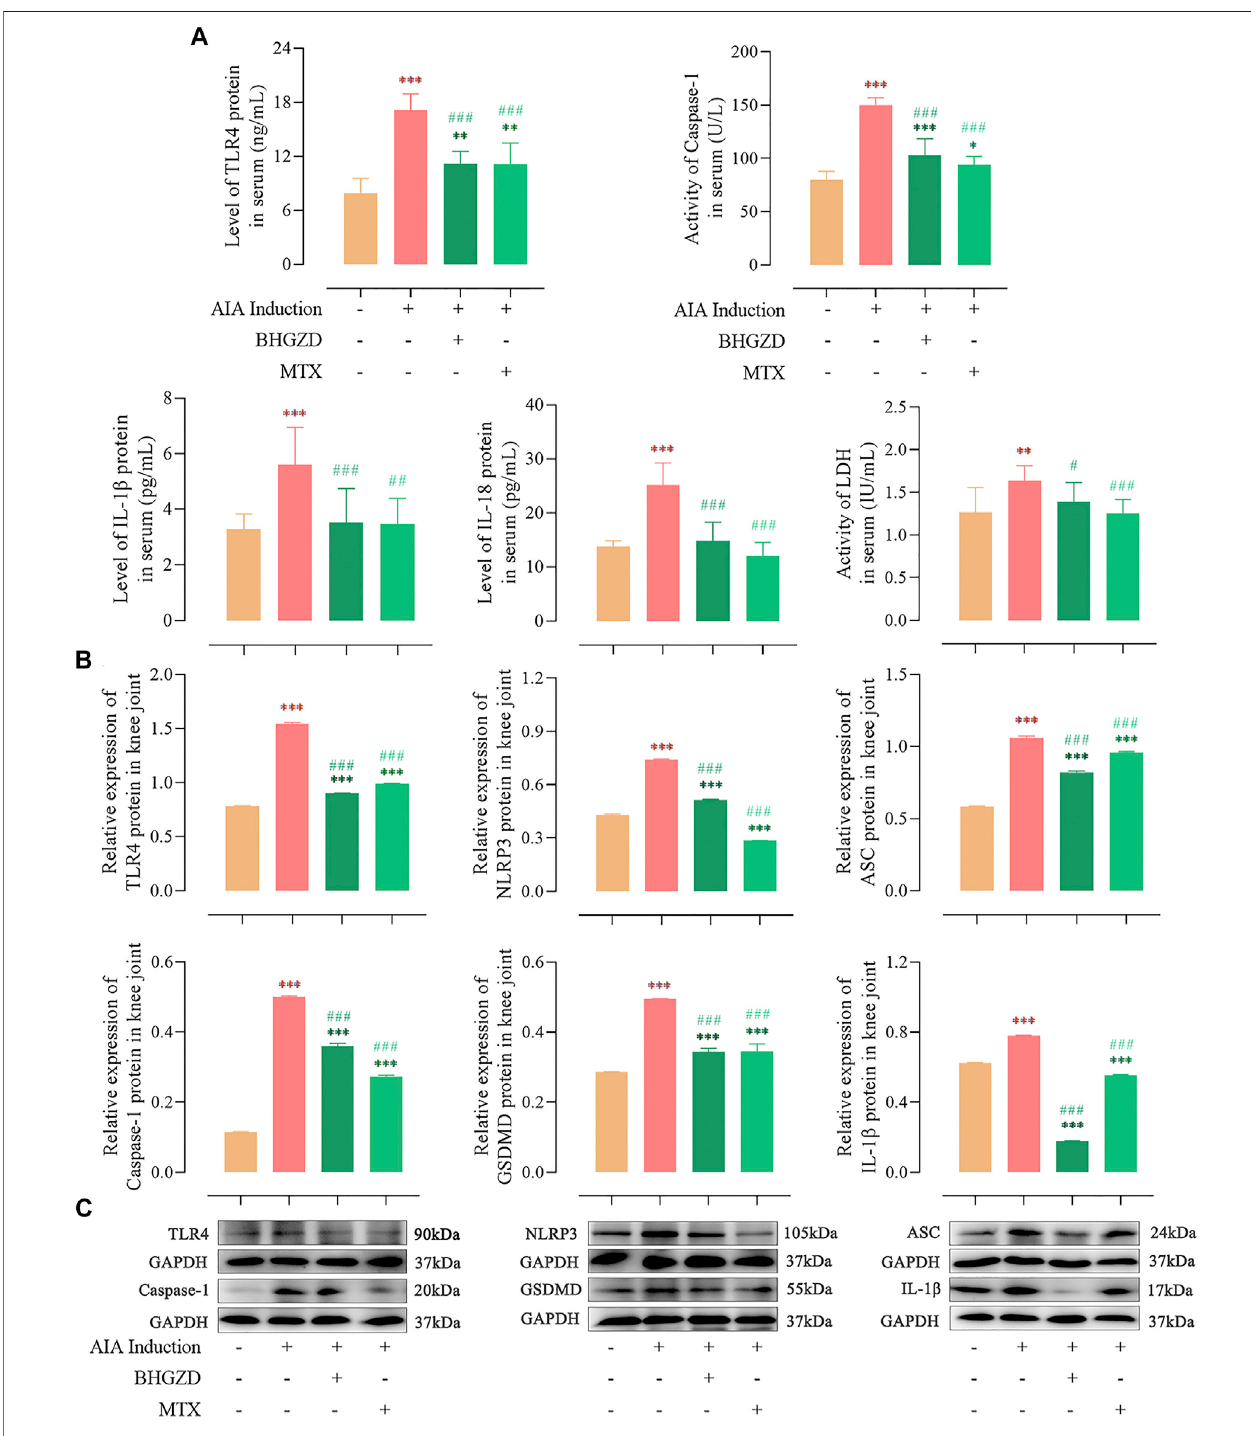
FIGURE 2 | Effects of BHGZD treatment on the expression of proteins of TLR4 – mediated NLRP3 in fl ammasome in AIA-M rats of different groups detected by ELISA and Western blotting. (A) Expression levels of TLR4, IL-1 β , and IL-18 proteins and activities of caspase-1 and LDH in the sera of AIA-M rats of different groups. (B ∼ C) ProteinexpressionlevelsofTLR4,NLRP3,ASC,caspase-1,GSDMD,andIL-1 β inthejointsofAIA-Mratsofdifferentgroups.*,**,and***, p < 0.05, p < 0.01,and p < 0.001, respectively, in comparison with the normal control group; #, ##, and ###, p < 0.05, p < 0.01, and p < 0.001, respectively, in comparison with the AIA- M